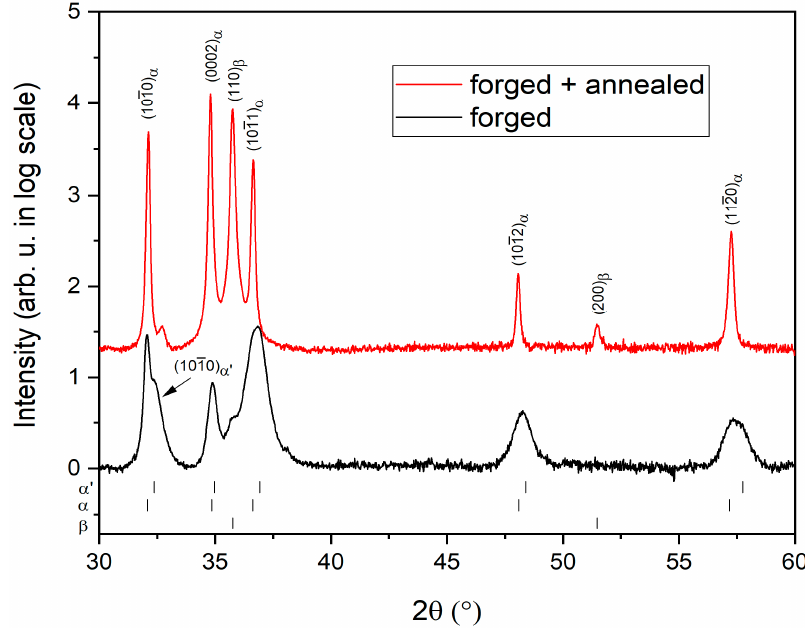
Figure 4. XRD patterns of forged and forged + aged Zr4Sn4Nb alloy. Microhardness values of individual conditions of both Zr-4Sn-4Nb and Zr-8Sn-4Nb alloys are plotted in Figure 5a. In the cast + homogenized condition, the microhardness is